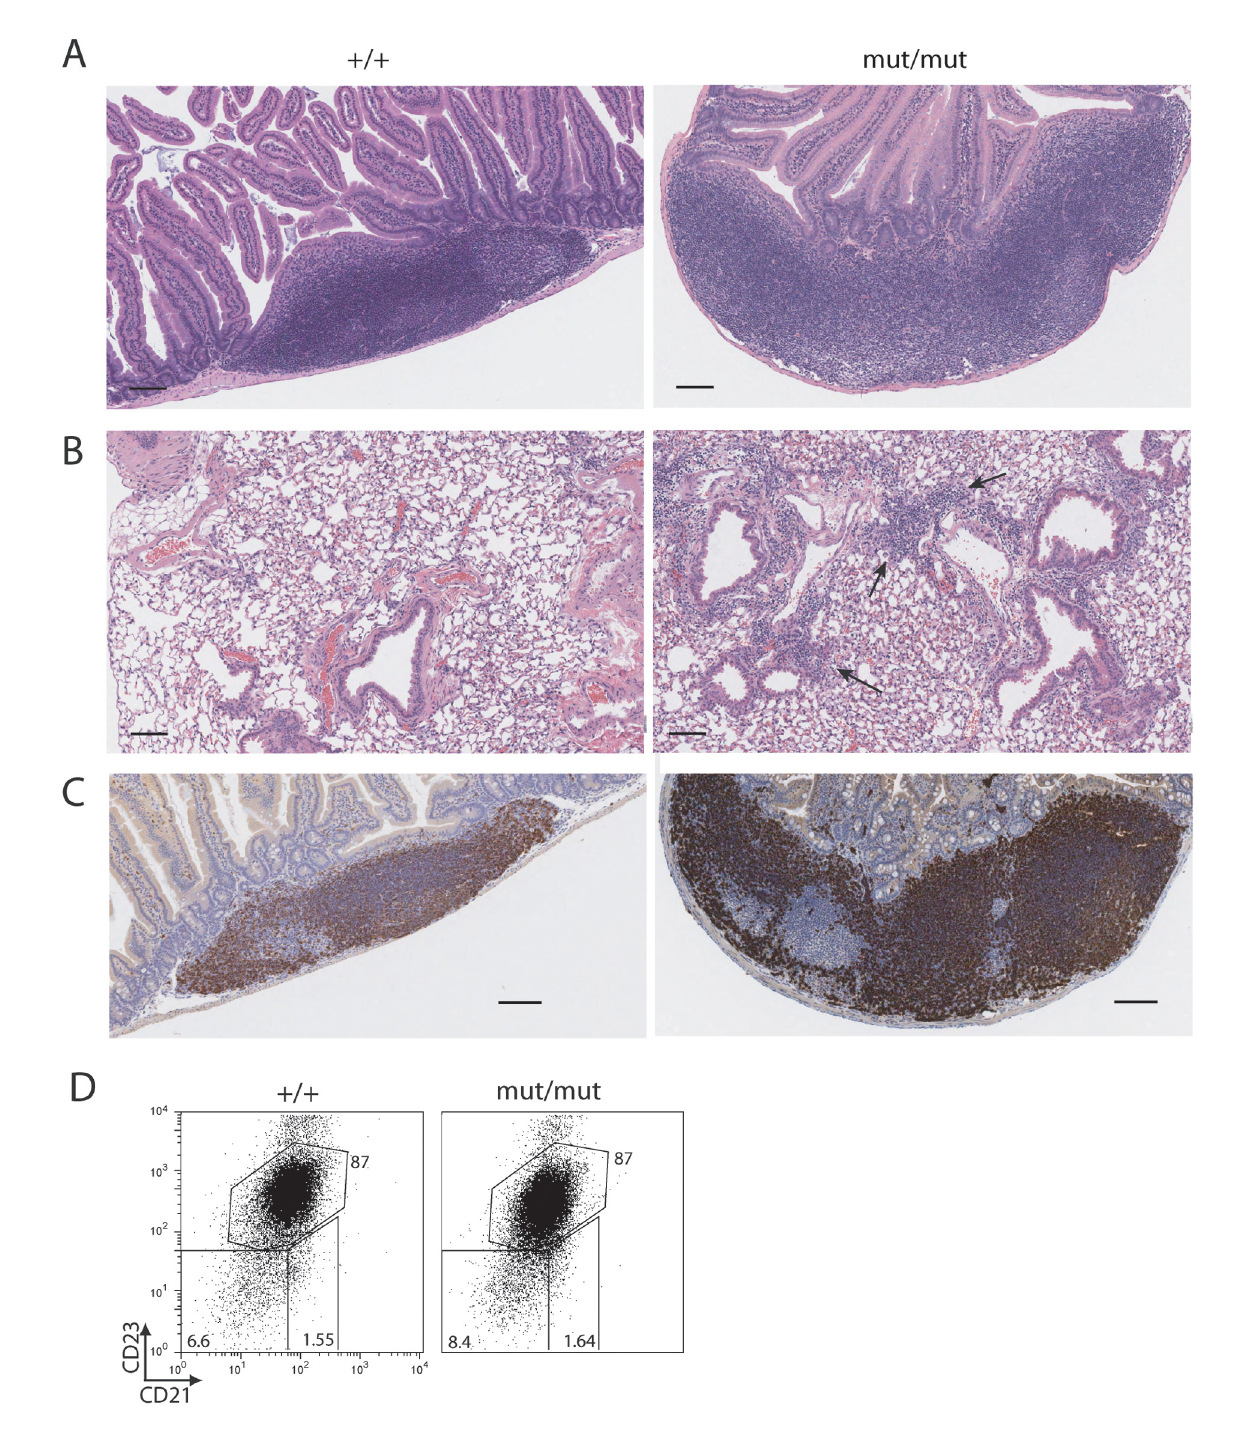
Figure 5. Lymphocytic infiltrates in the lungs and GALT hyperplasia in c-IAP2 H570A/H570A mice. Sections of GALT (A) and lung (B) from wild type ( + / + ) and c-IAP2 knockin (mut/mut) mice stained with hematoxylin and eosin. Both tissues are presented at 8 6 magnification and the bar denotes 100 m m. Arrows highlight the areas containing the infiltrating lymphocytes in the lungs of c-IAP2 H570A/H570A mice. (C) B cell distribution in GALT of + / + and mut/mut mice. (D) Distribution of immature (CD23 2 CD21 2 ), follicular (CD23 + CD21 int ), and marginal zone (CD23 2 CD21 + ) B cells (gated on B220 + cells) in GALT of + / + and mut/mut mice. Numbers represent the percent positive in each gate.